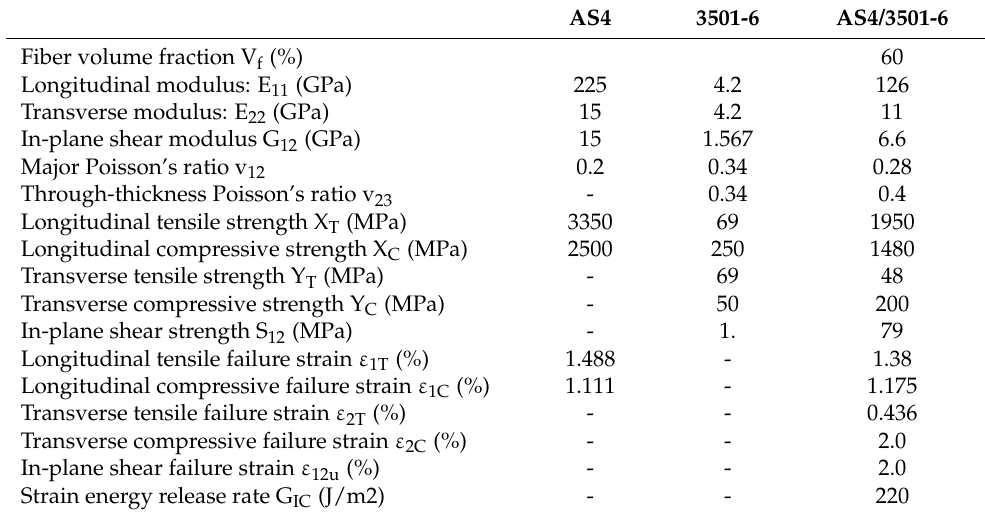
Table 4. The measured mechanical properties of constituents and the unidirectional lamina